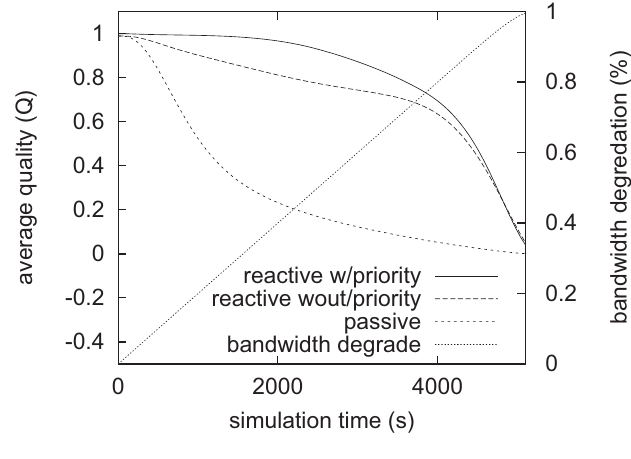
Figure 9. Quality adapting to link bandwidth degradation using different QSS configurations.